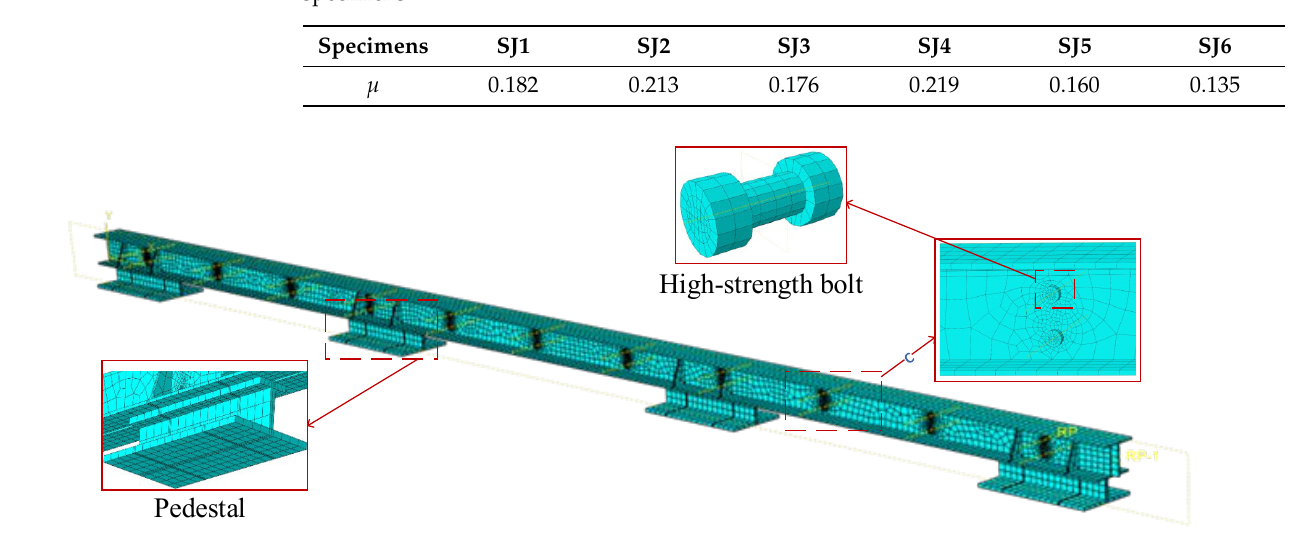
Figure 12. The finite element model of the friction energy dissipation composite chord.